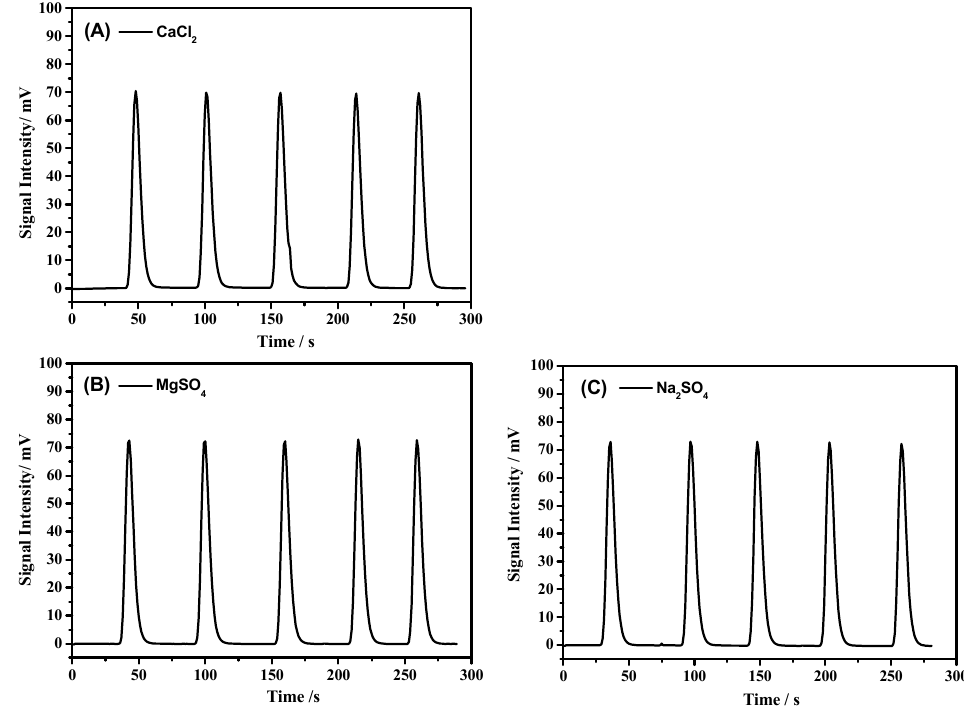
Figure 7. Adsorption performance of desiccants on CO 2 tested with pulse adsorption, ( A ) CaCl 2 , ( B ) MgSO 4 , ( C ) Na 2 SO 4 .